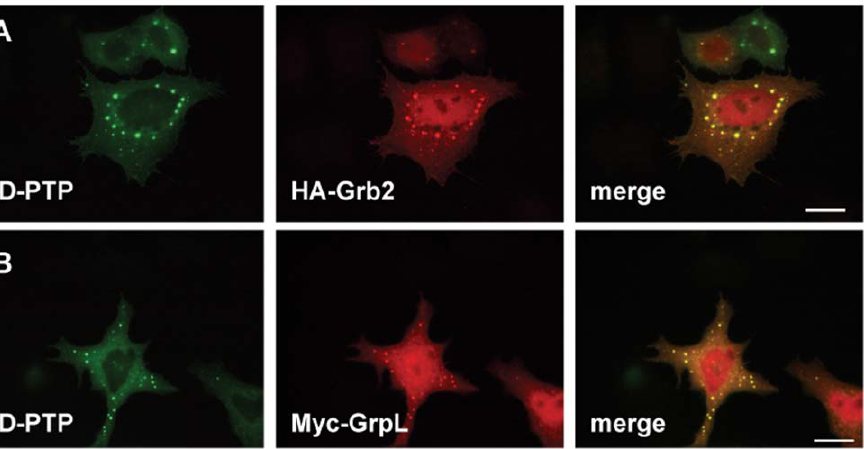
Figure 3. EGFP-HD-PTP partially co-localizes with HA-Grb2 and Myc-GrpL to endosomes. HeLa cells were transfected with plasmids expressing EGFP-HD-PTP and either HA-Grb2 (A) or Myc-GrpL (B). 18–24 h post-transfection, the cells were fixed, permeabilized and incubated with anti-Myc or anti-HA antibodies, followed by incubation with secondary antibodies labeled with AlexaFluor 594. Mounted coverslips were imaged with a fluorescence microscope. Scale bars, 20 m m.